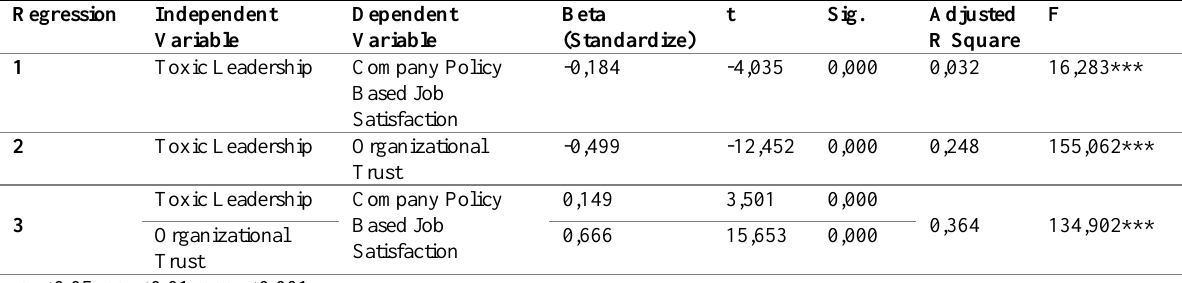
Table 7: The Effect of Toxic Leadership on Company Policy Based Job Satisfaction through the Mediation of